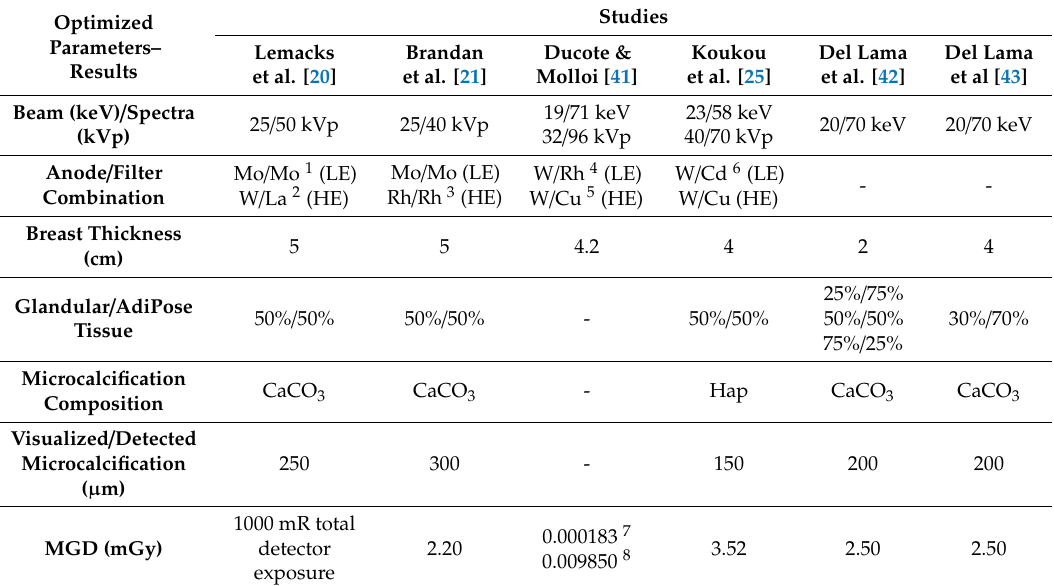
Table 1. Optimized parameters and results of the simulation